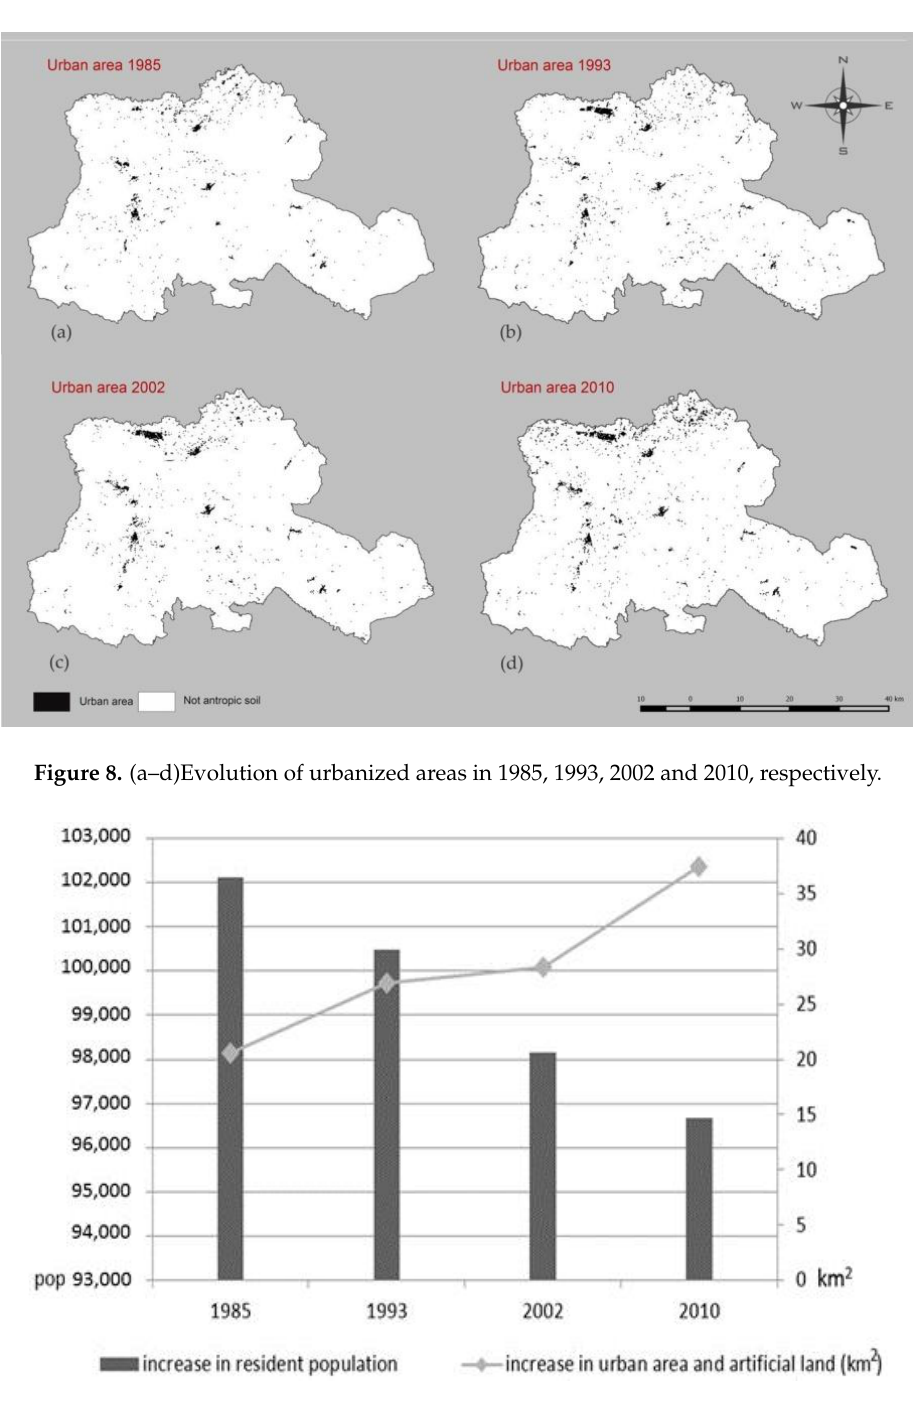
Figure 9. Comparison of the increase in population and the increase in urbanized areas between 1985 and 2010; elaboration on the data from the Italian National Institute of Statistics.